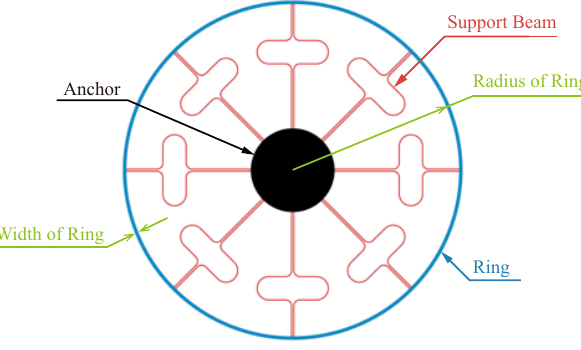
Figure 2. The schematic of the vibrating ring gyroscope